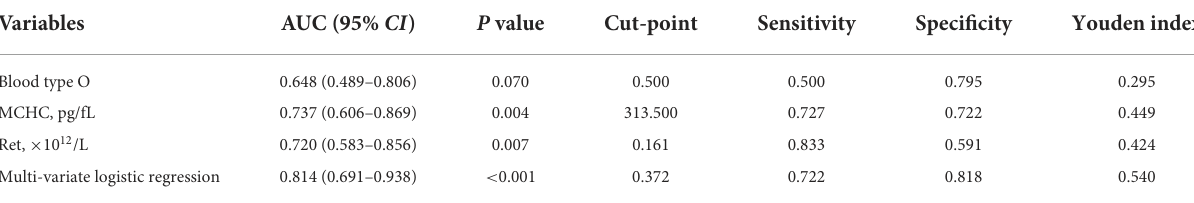
TABLE 3 The area under the curve (AUC) and Youden Index of single significant variables and the multivariate logistic regression model.